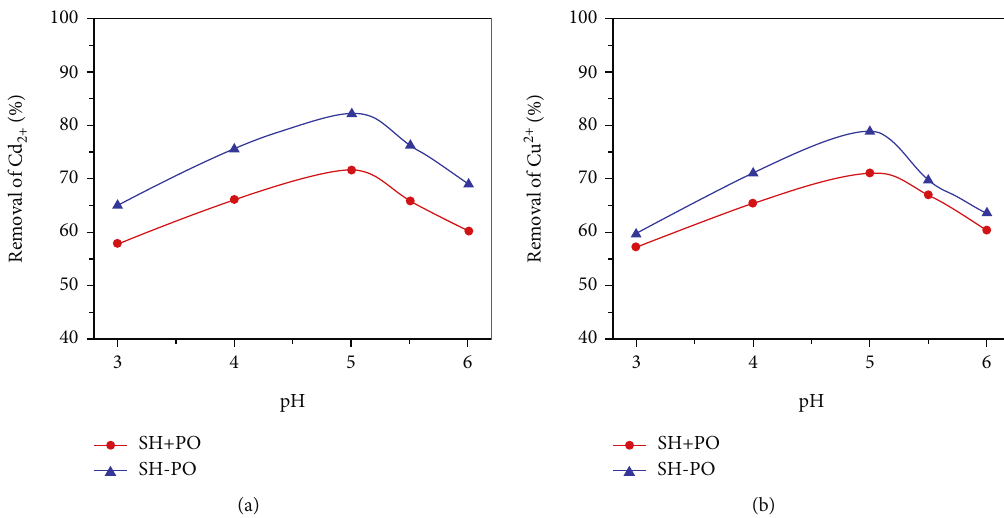
Figure 4: E ff ect of solution pH on (a) Cd 2+ and (b) Cu 2+ removal by soybean